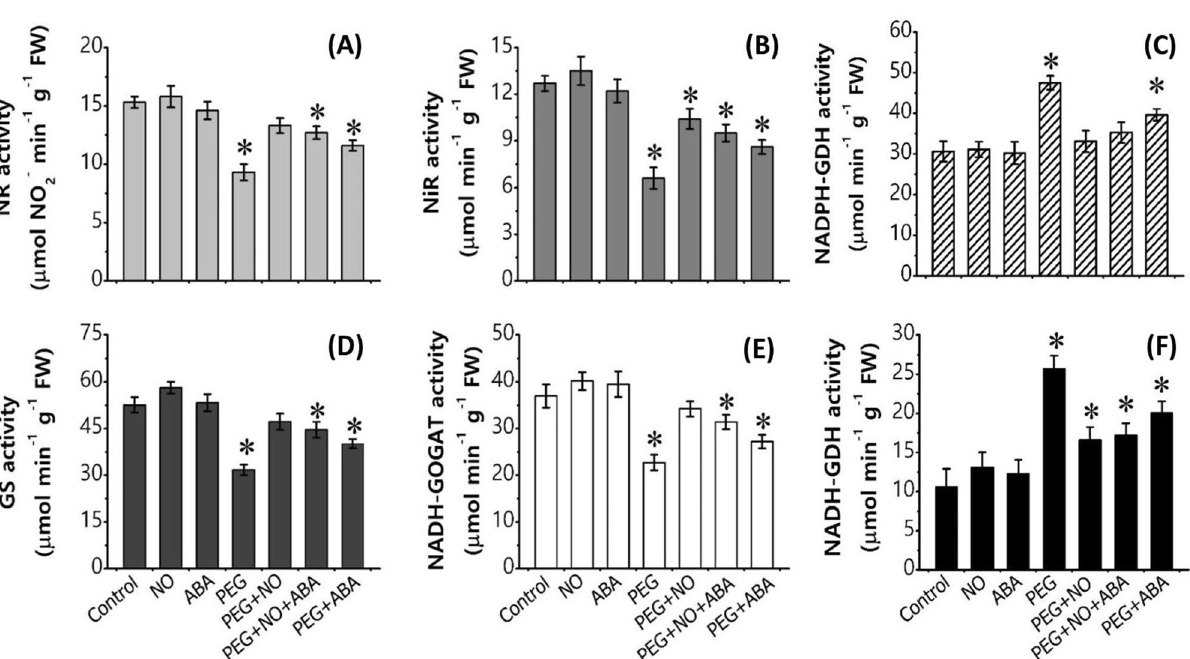
Figure 4. Activity of nitrate reductase (NR), nitrite reductase (NiR), glutamine synthetase (GS), glutamate synthase (GOGAT) and glutamate dehydrogenase (NADPH-GDH and NADH-GDH) of 7-day-old B. juncea L. roots after treatment with PEG (10%) and its combination with NO (100 µM) and ABA (10 µM) (nitrate agonists) for 96 h. Values are mean ± S.E. of three independent experiments, each including four biological replicates. Asterisk (*) indicates significant difference compared with control (* p <